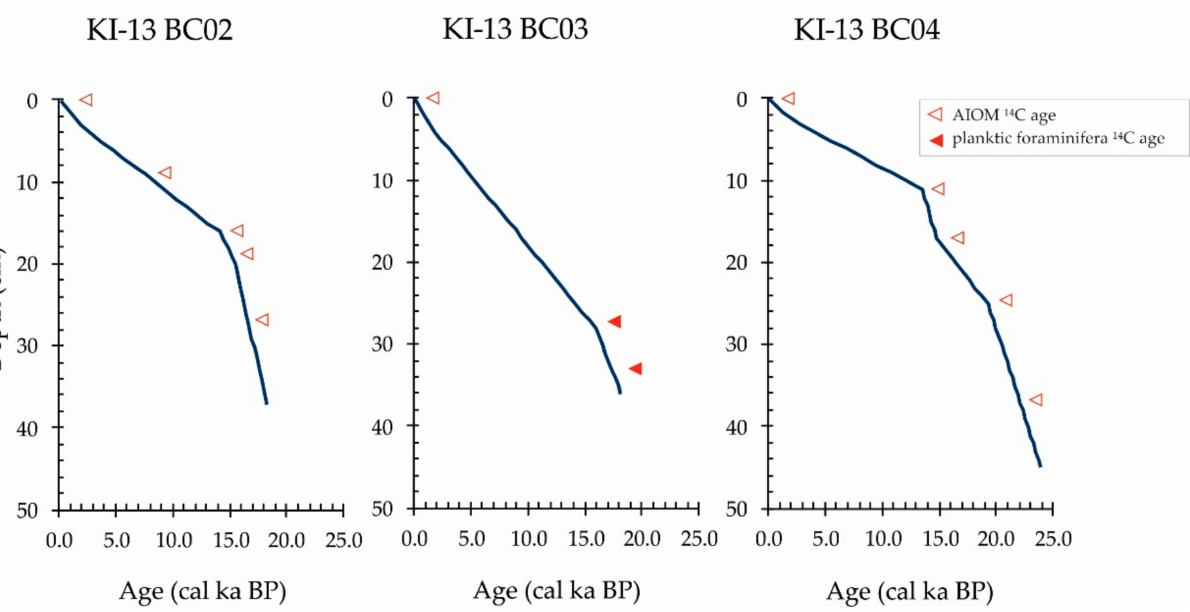
Figure 3. Age–depth model based on the linear interpolation of best point calibration ages from